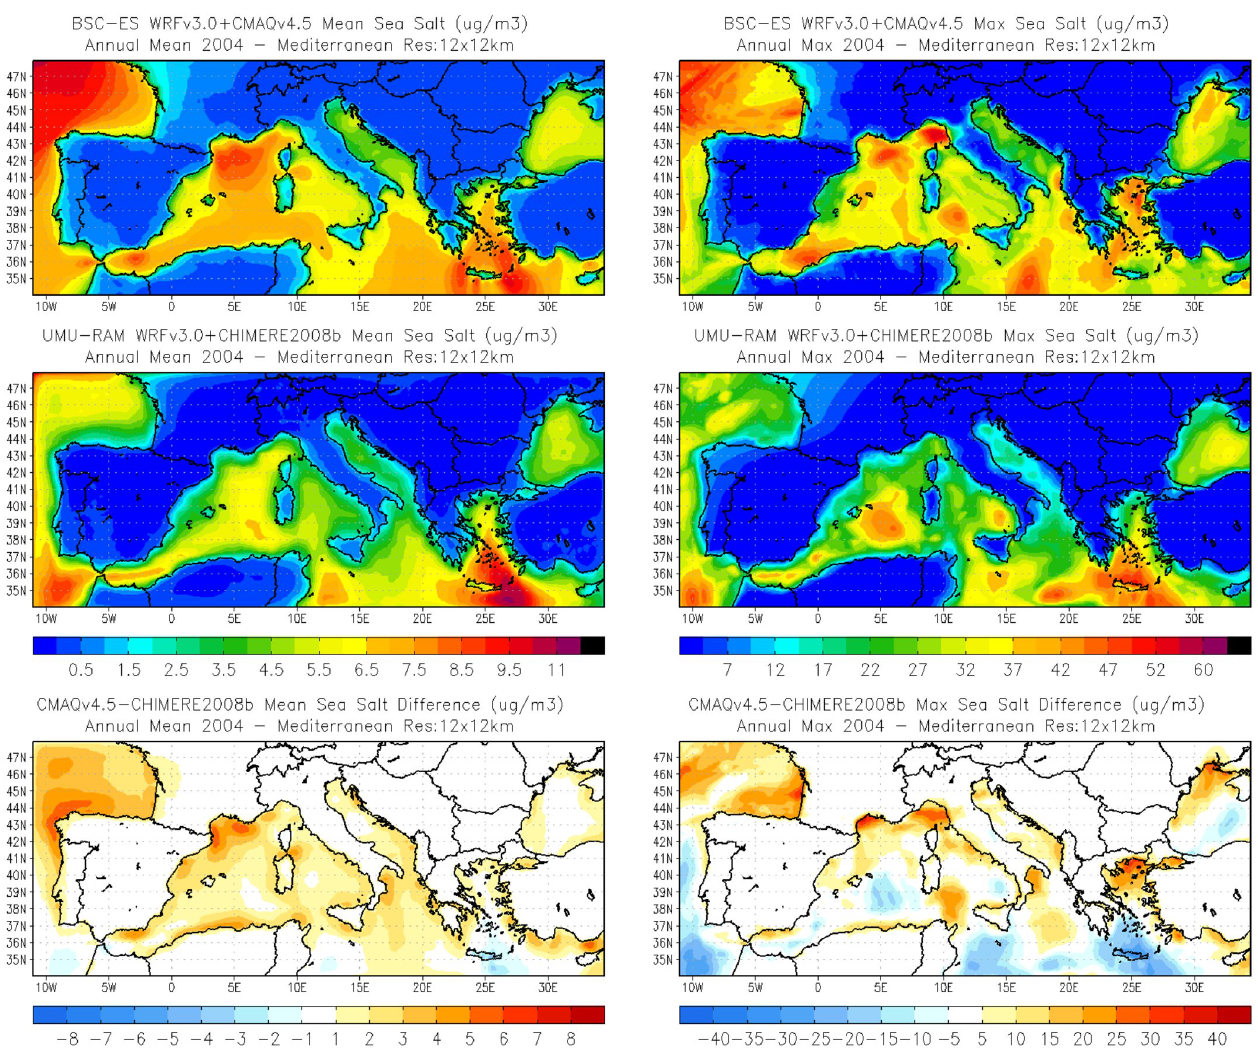
Fig. 3. (Left) modeled annual mean SSA concentration (µgm − 3 ) for WRF + CMAQ (top), WRF + CHIMERE (center) and difference between CMAQv4.5-CHIMERE2008b mean SSA concentrations (bottom); (right) modeled annual maximum SSA concentration (µgm − 3 ) for WRF + CMAQ (top), WRF + CHIMERE (center) and difference between CMAQv4.5-CHIMERE2008b maximum SSA concentrations (bottom).